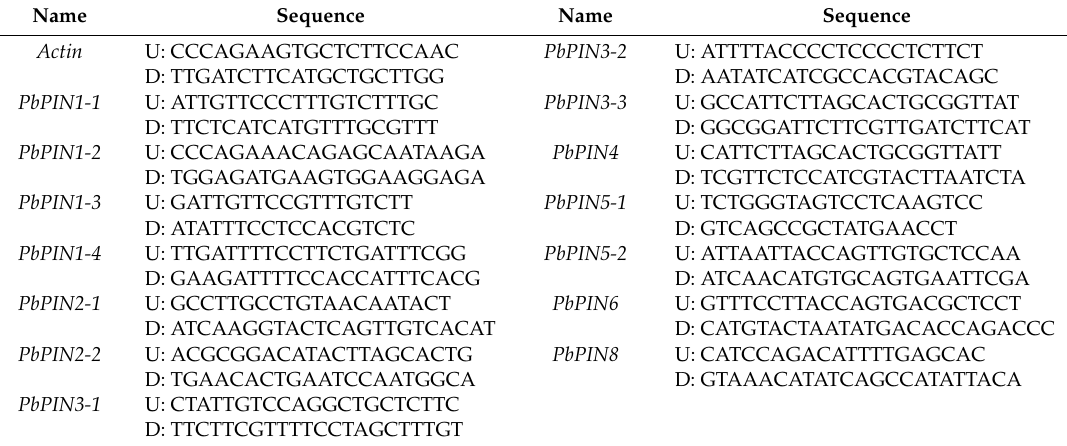
Table 4. The primer of the RT-PCR